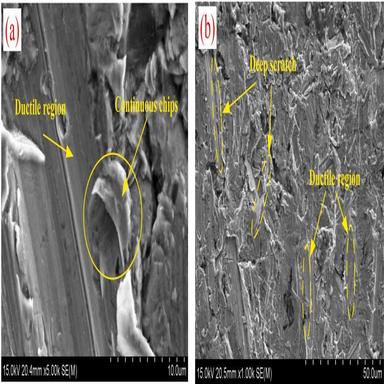
SEM images of the matrix bond.